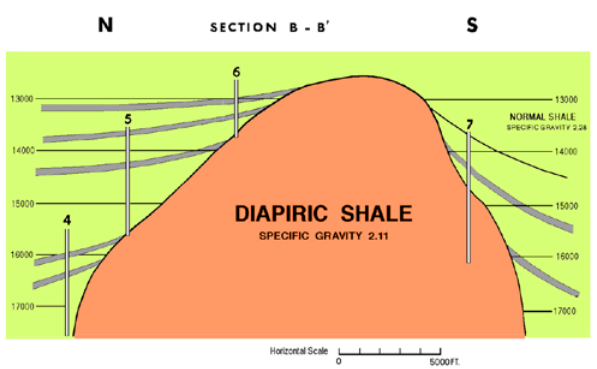
Figure 35. This intrusive shale mass is near Eugene Island, Texas gulf coast. Gilreath 13 , 1968, fig. 9.